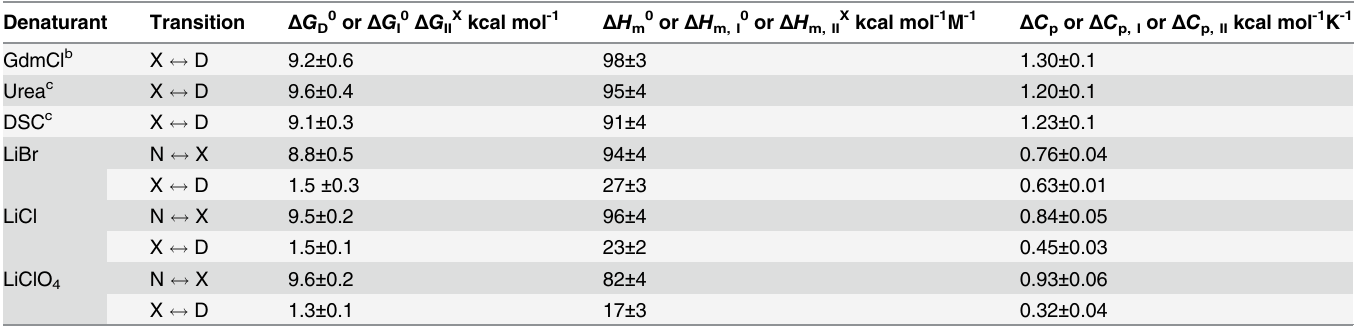
Table 3. Comparison of thermodynamic parameters of cyt- c in the presence of different denaturants at pH 6.0 and 25 o C a ,. Denaturant